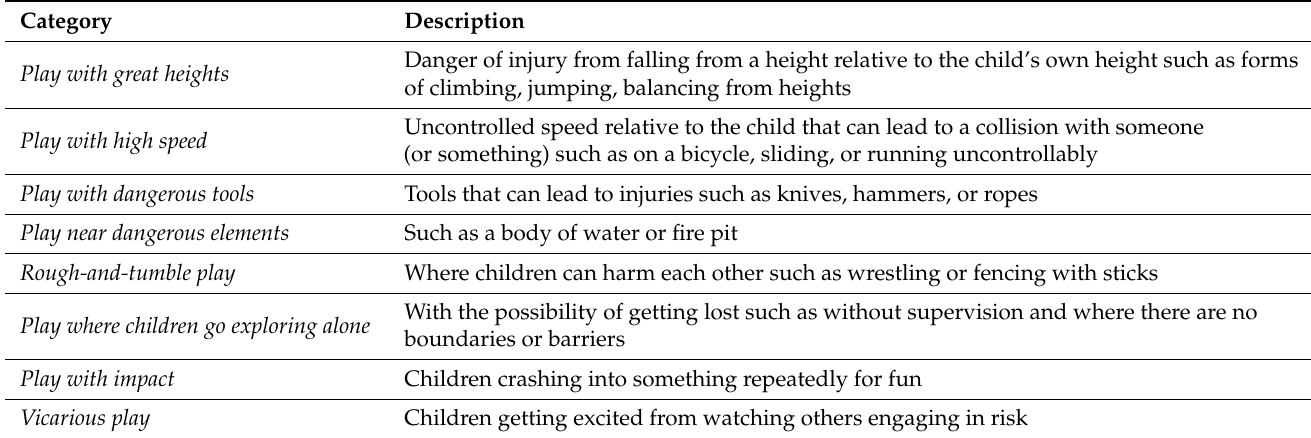
Table 6. Categories of risky play (adapted from